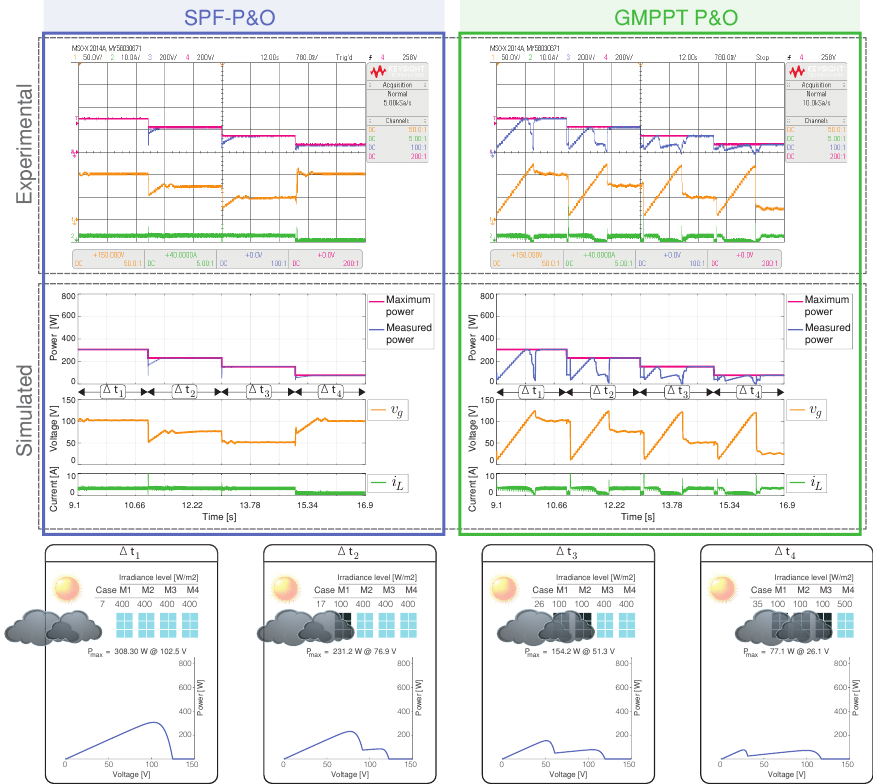
Figure 13. Simulated and experimental dynamic behavior of the MPPT algorithms for Scenario 5 with an output voltage V o = 160 V. The proposed MPPT algorithm (right) is compared with the GMPPT P&O algorithm (right). CH1: v g (50 V/div), CH2: i L (10 A/div), CH3: Maximum power (200 W/div), CH4: Measured power (200 W/div) and a time base of 780